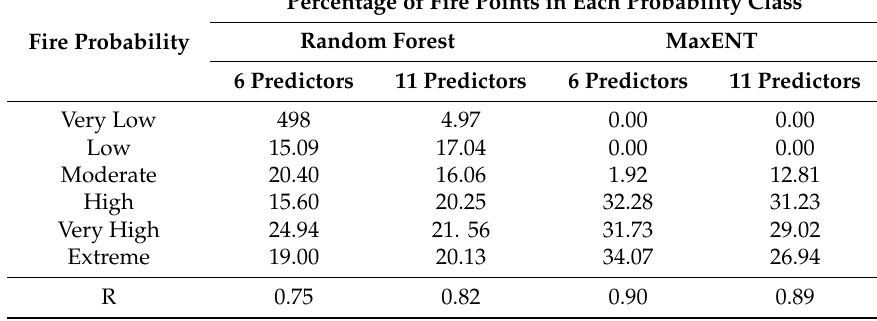
Table 5. Comparison of the di ff erent types of long-term wildfire presence probability modeling methods in Nyurbinsky